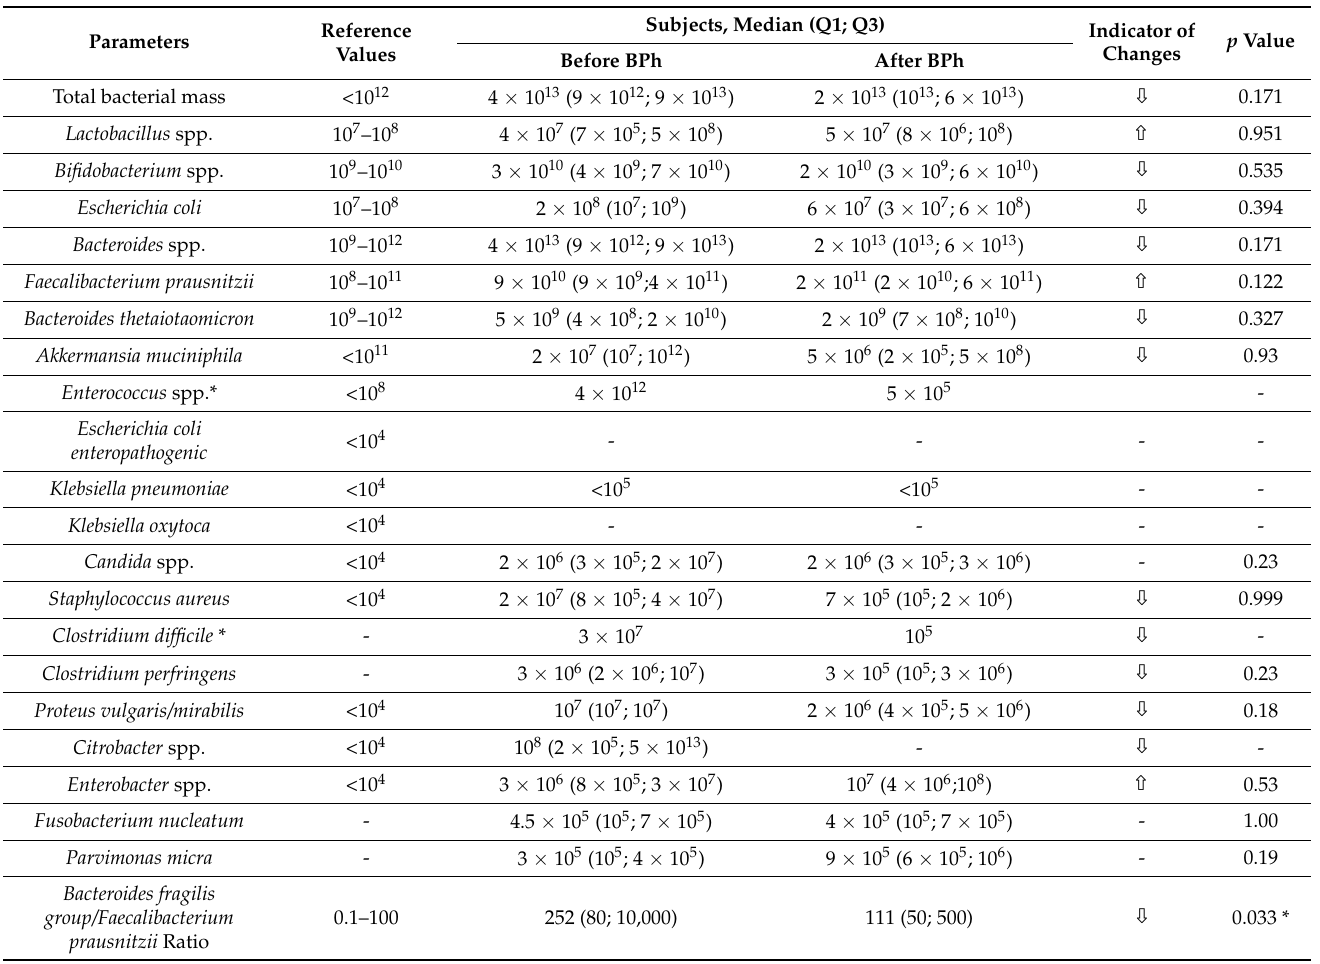
Table 3. Taxonomic abundance of the gut microbiota in subjects before and after the bacteriophage therapy (BPh). * Correlation is statistically significant.